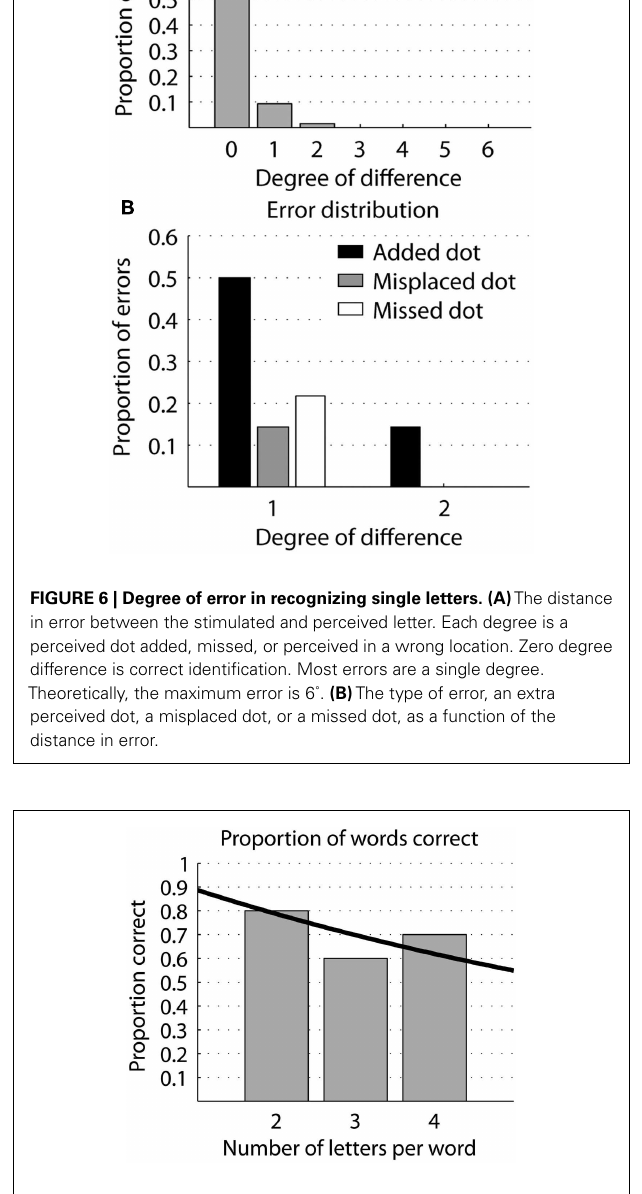
FIGURE 7 | Recognition of braille words. Proportion correct identification of 2-, 3-, and 4-letter words. Black line represents the expected proportion correct given a proportion of single letter identification rate of